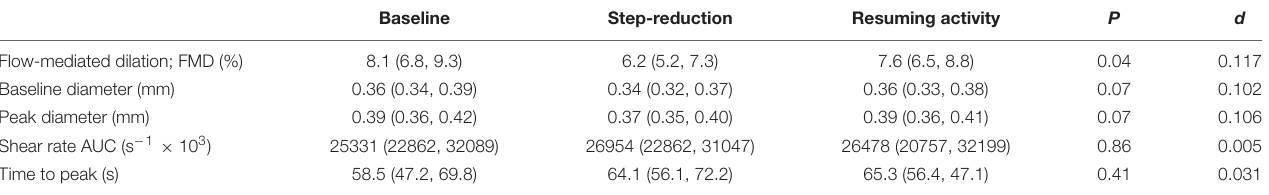
TABLE 2 | Data of the brachial artery vascular function at baseline, following 14 days of physical inactivity and 14 days resumption to habitual activity. Baseline Step-reduction Resuming activity P